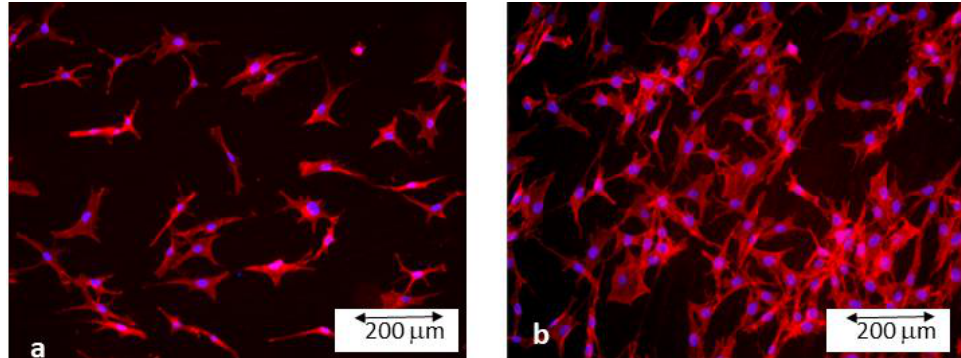
Figure 6. Human-osteoblast cells on NiTi with silver nanoparticles ( a ) after 24 h on metallic surface. ( b ) After 3 days.